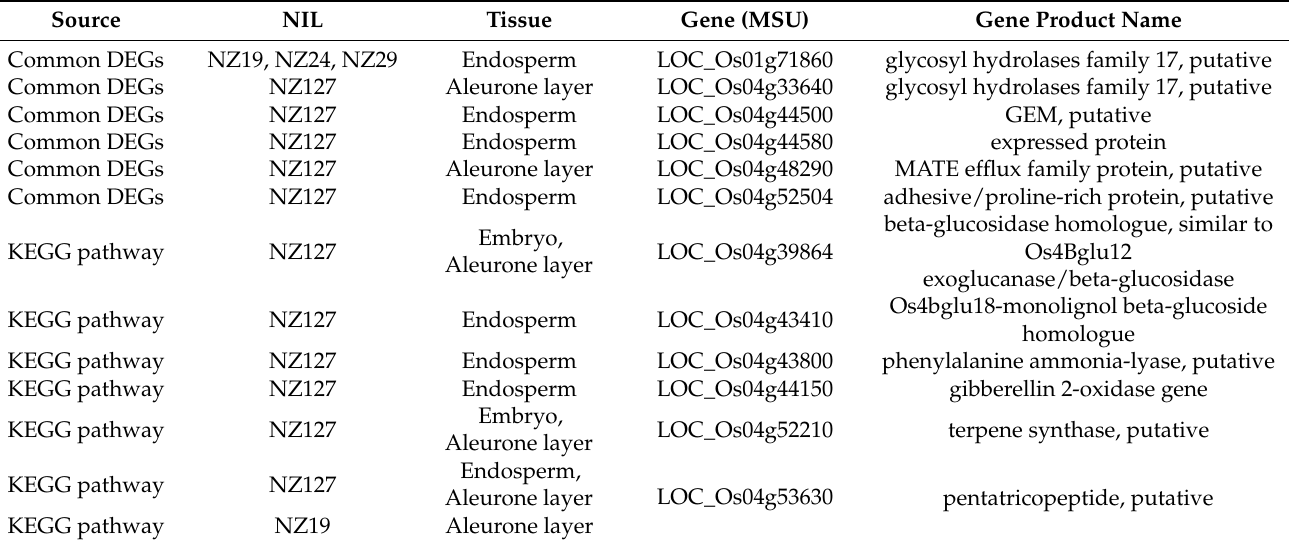
Table 4. Information of 12 candidate genes.